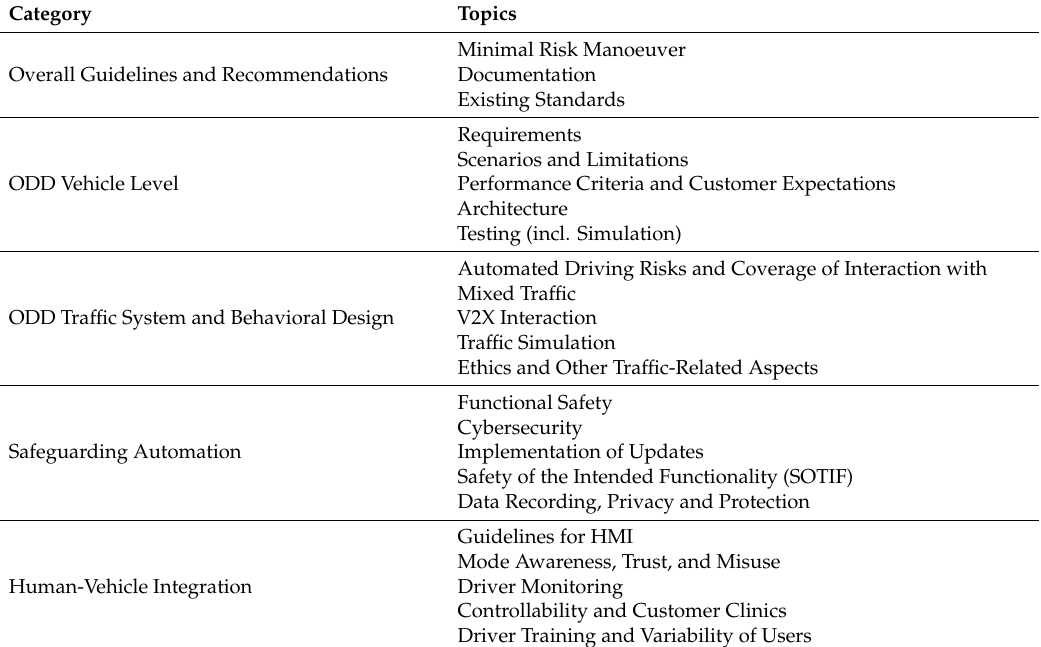
Table 2. Categories and topics. HMI: Human–Machine Interface, ODD: Operational Design